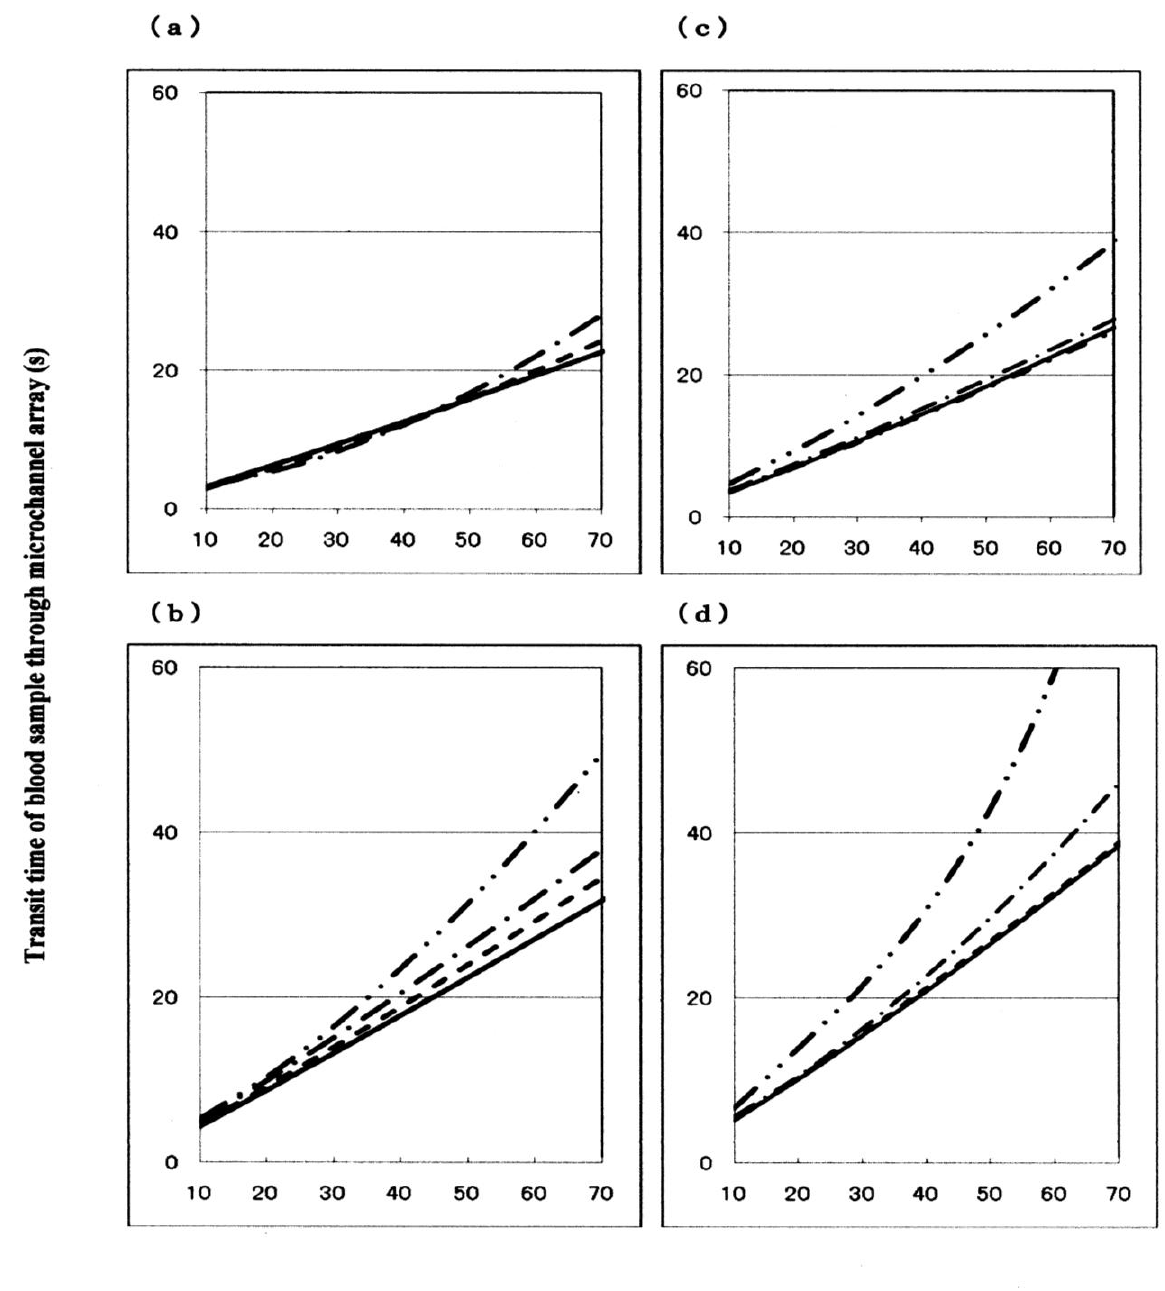
Figure 8. Representative examples ( n = 4) of blood fluidity measured in terms of transit time against transit sample volume. Solid lines represent the temperature-untreated control; broken lines represent samples treated at 37 °C; one-point lines represent samples treated at 42 °C; and two-point lines represent samples treated at 45